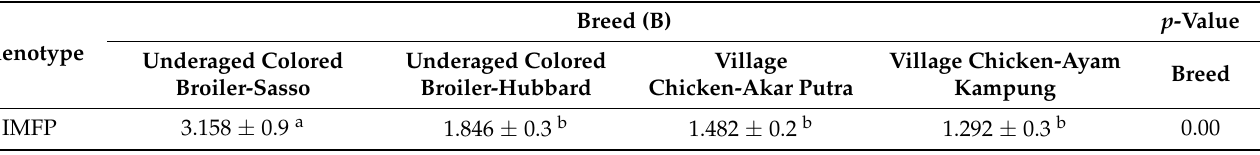
Table 6. Effect of breed on intramuscular fat content of breast muscle in four chicken breeds. Breed (B) p -Value Phenotype Underaged Colored Underaged Colored Village Village Chicken-Ayam Broiler-Sasso Broiler-Hubbard Chicken-Akar Putra